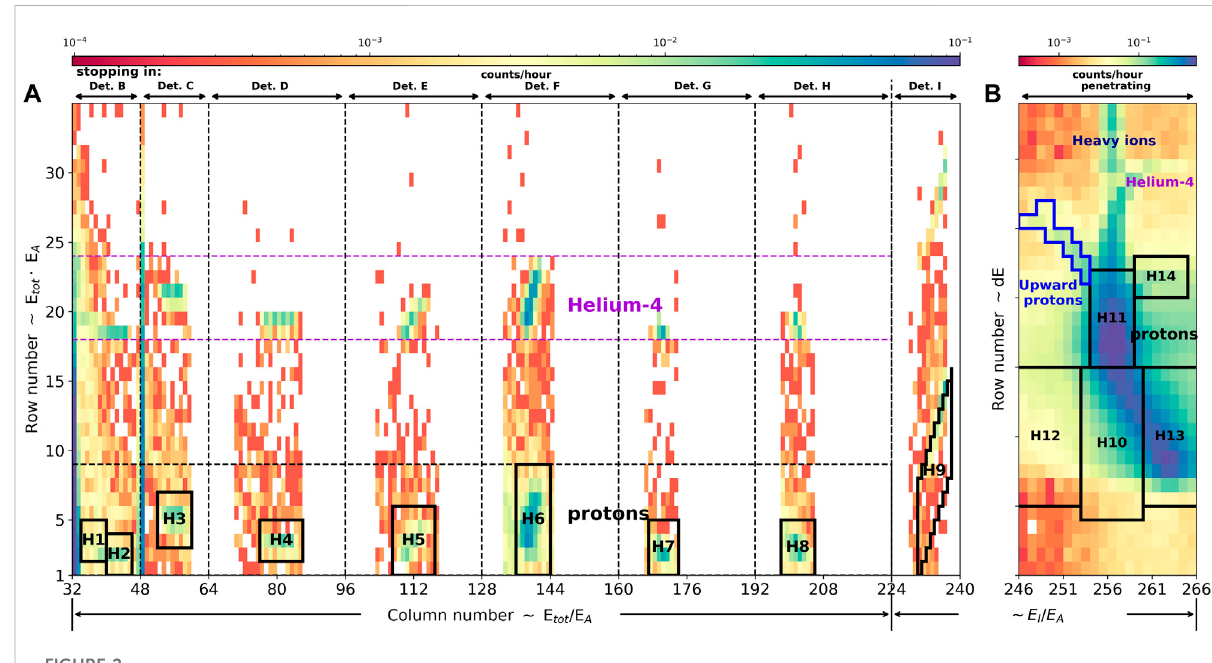
FIGURE 2 The (A) paneldisplaysthe “ Xmasplot ” ofpartofthechargedparticlesstoppingbetweendetectorsBandI.Theemptyarearepresentsthepartof the LND memory that is not transmitted to the ground. Panel (B) is the Xmas plot between columns 246 and 266. The primary proton channels and albedoprotonchannelarede fi nedaccordinglyinthosetwopanels,markedbyblackandblueboxes.Thequantitiesusedtocalculatetheentry “ pixel ” in the Xmas plot are calculated according to the quantities summarized in Tab. 5 in Wimmer-Schweingruber et al.